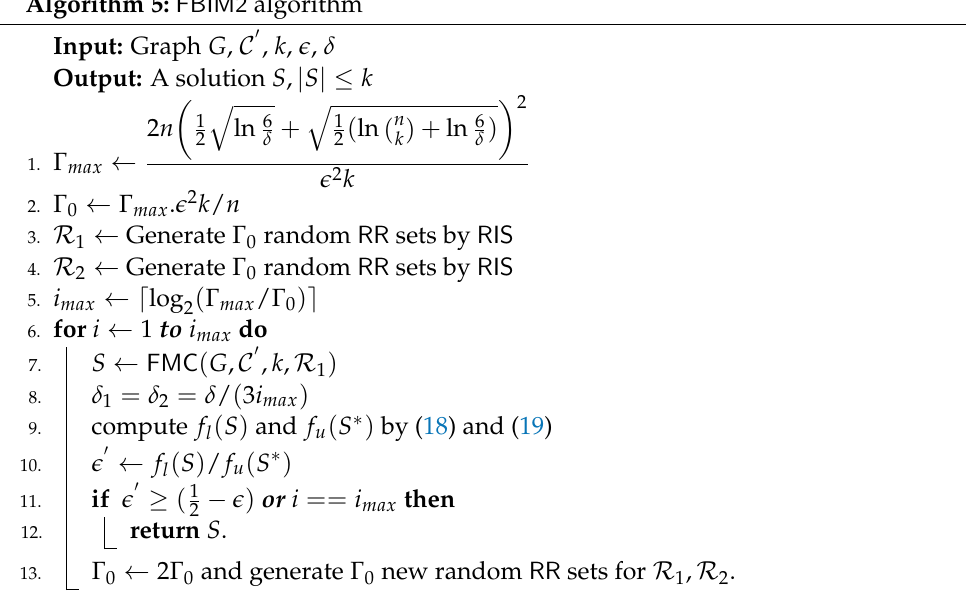
Algorithm 5: FBIM2 algorithm